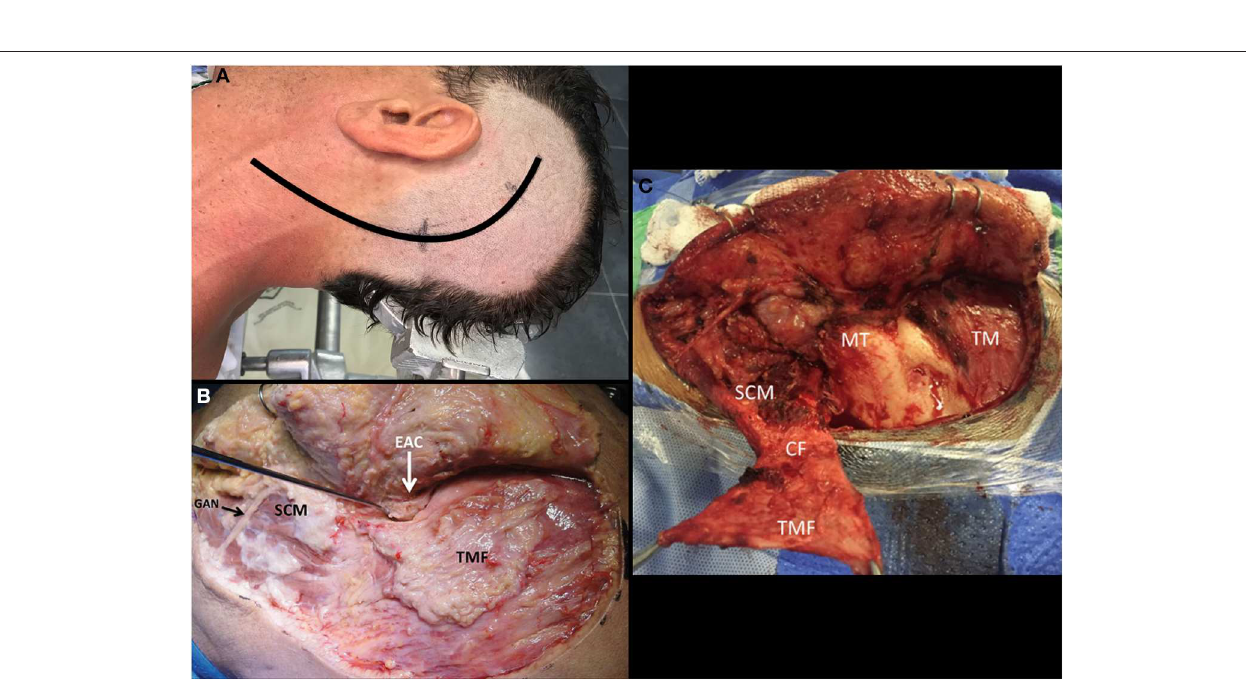
FIGURE 11 | Left-sided craniocervical approach [Modified from Ramina and Tatagiba (3)]. (A) Head positioning and incision. (B) Suprafascial dissection exposing the temporalis muscle fascia and cervical fascia. (C) Creating the temporo-cervical-SCM flap to close the surgical defect after surgery. CF, cervical fascia; EAC, external auditory canal; GAN, great auricular nerve; MT, mastoid tip; SCM, Sternocleidomastoid muscle; TM, temporalis muscle; TMF, temporalis muscle fascia.